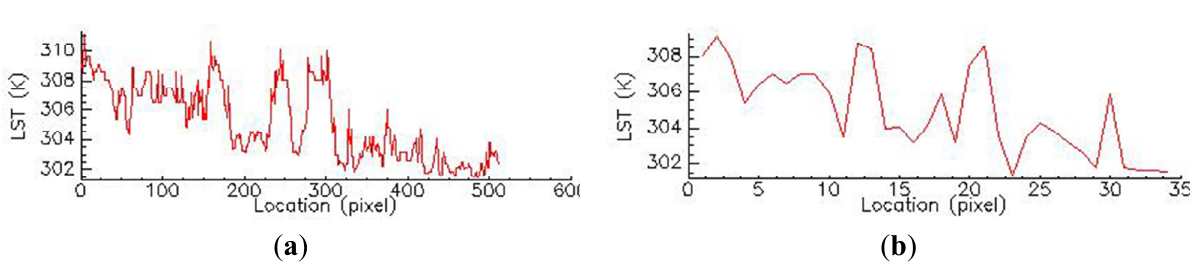
Figure 5. Transactions derived from LST data at 60 m and 900 m scales. ( a ) Temperature profile at 60m scale; ( b ) Temperature profile at 90m